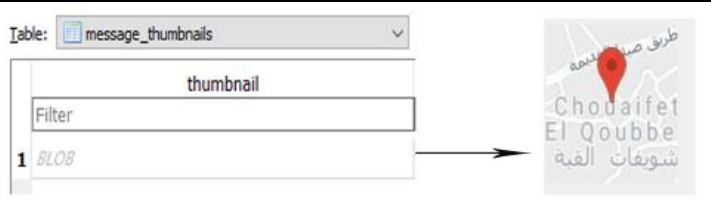
Figure 18. Thumbnail of the location from the table